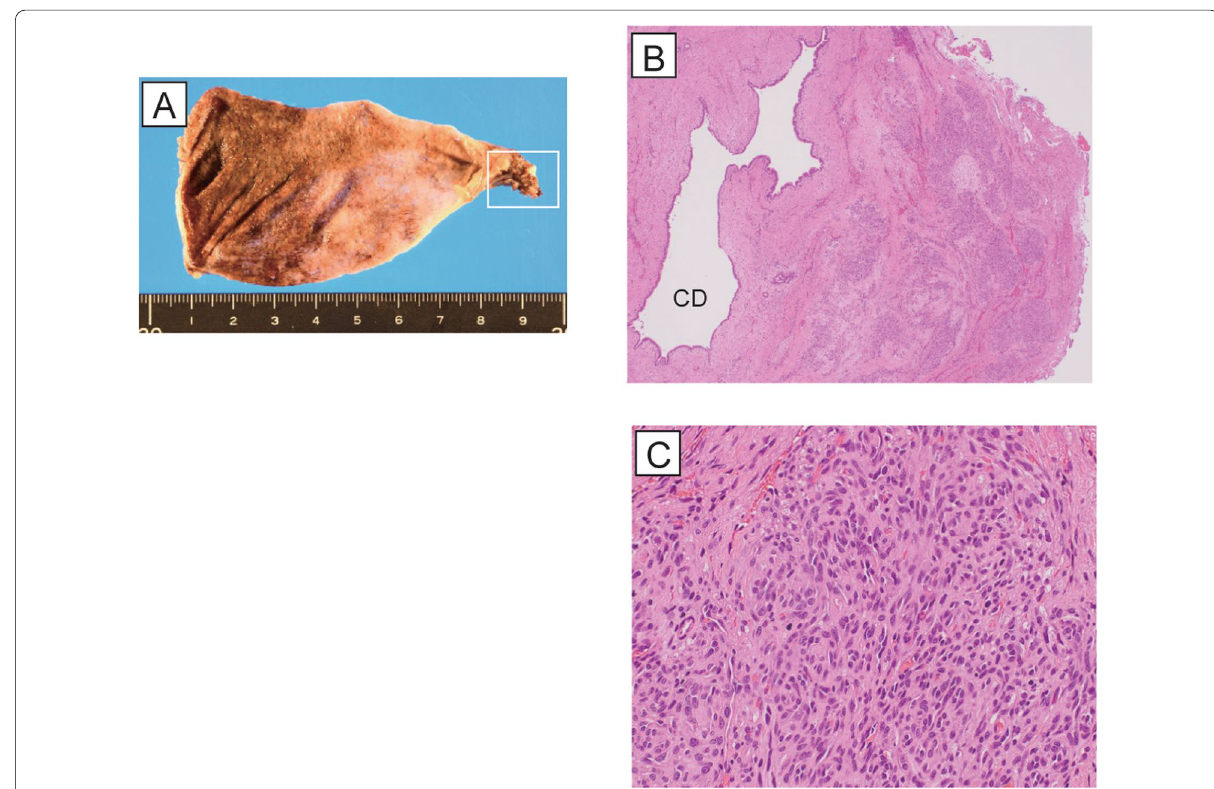
Fig. 3 Histopathological findings of the cystic duct. A Macroscopic findings of the gallbladder. The cystic duct positioned close to the hepatoduodenal ligament is a clue to the diagnosis of Kaposiform hemangioendothelioma (white line square). B H&E stained section of the peri-cystic duct. Hypervascular and polynodular lesions were observed around the resected CD ( peri-cystic duct. Proliferated spindle cells formed slit-like lumens filled with red blood cells (